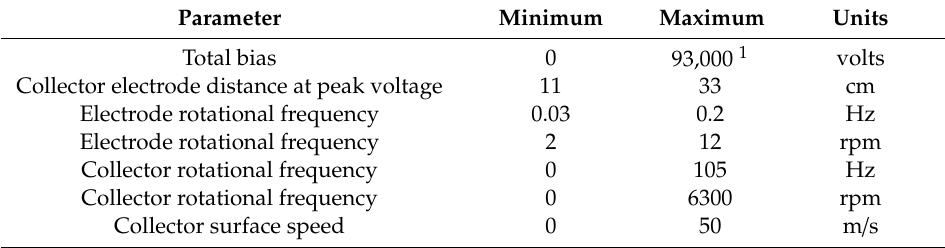
Table A5. Range of possible system parameters capable of being studied with this device.